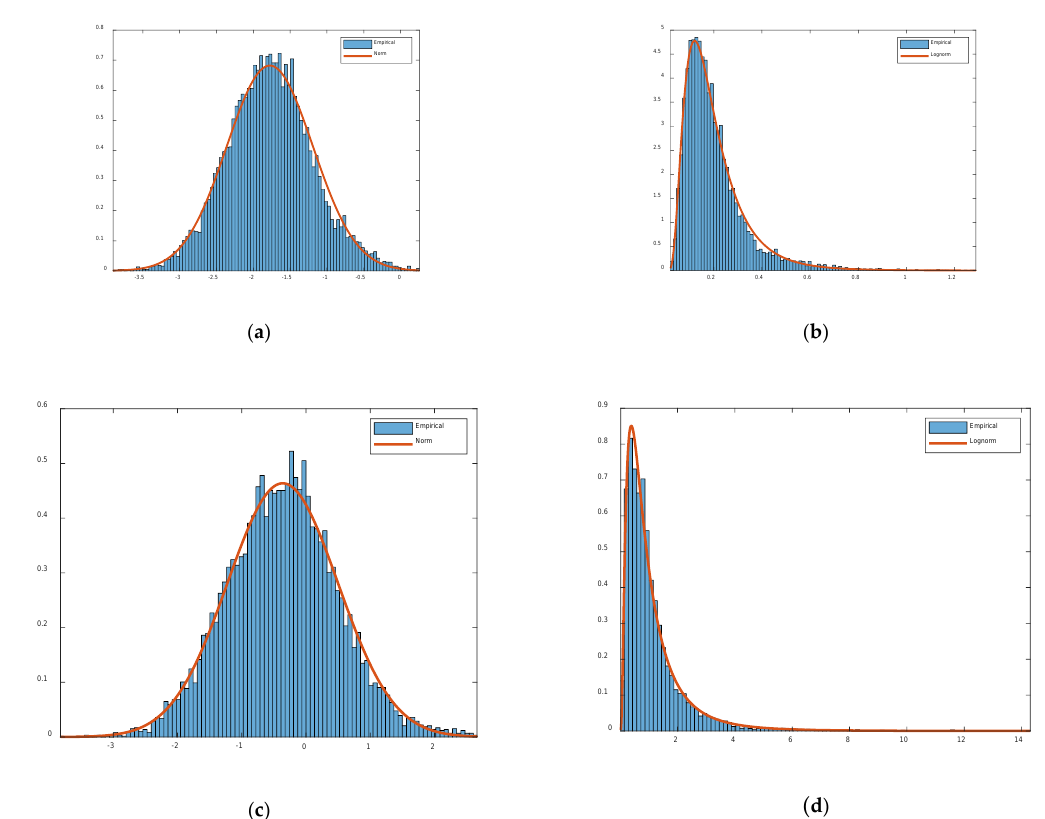
Figure 10. Probability Density Function (PDF) of log( α ( t 0 + Δ t k )), α ( t 0 + Δ t k ) in both a silent environment and a dynamic environment. ( a ) PDF of log α ( t 0 + Δ t k ) in a silent environment; ( b ) PDF of α ( t 0 + Δ t k ) in a silent environment; ( c ) PDF of log α ( t 0 + Δ t k ) in a dynamic environment; ( d ) PDF of α ( t 0 + Δ t k ) in a dynamic environment;.